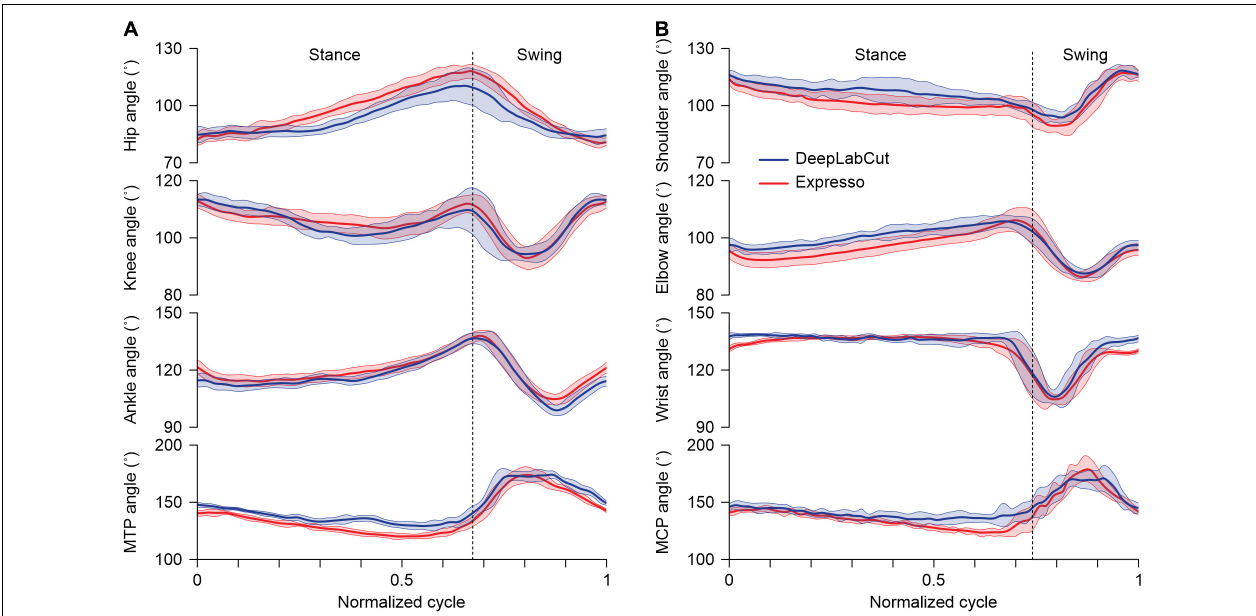
FIGURE 4 | Averaged angular displacements for the right hindlimb and forelimb across the step cycle. (A) Averaged angular displacements (mean ± SD) at the hip, knee, ankle, and metatarsophalangeal (MTP) joints in the right hindlimb of an intact adult cat at a tied-belt speed of 0.4 m/s ( n = 14 cycles). (B) Averaged angular displacements (mean ± SD) at the shoulder, elbow, wrist, and metacarpophalangeal (MCP) joints in the right forelimb of an intact adult cat at a tied-belt speed of 0.4 m/s ( n = 14 cycles). The vertical dotted lines mark swing onset in (A,B)